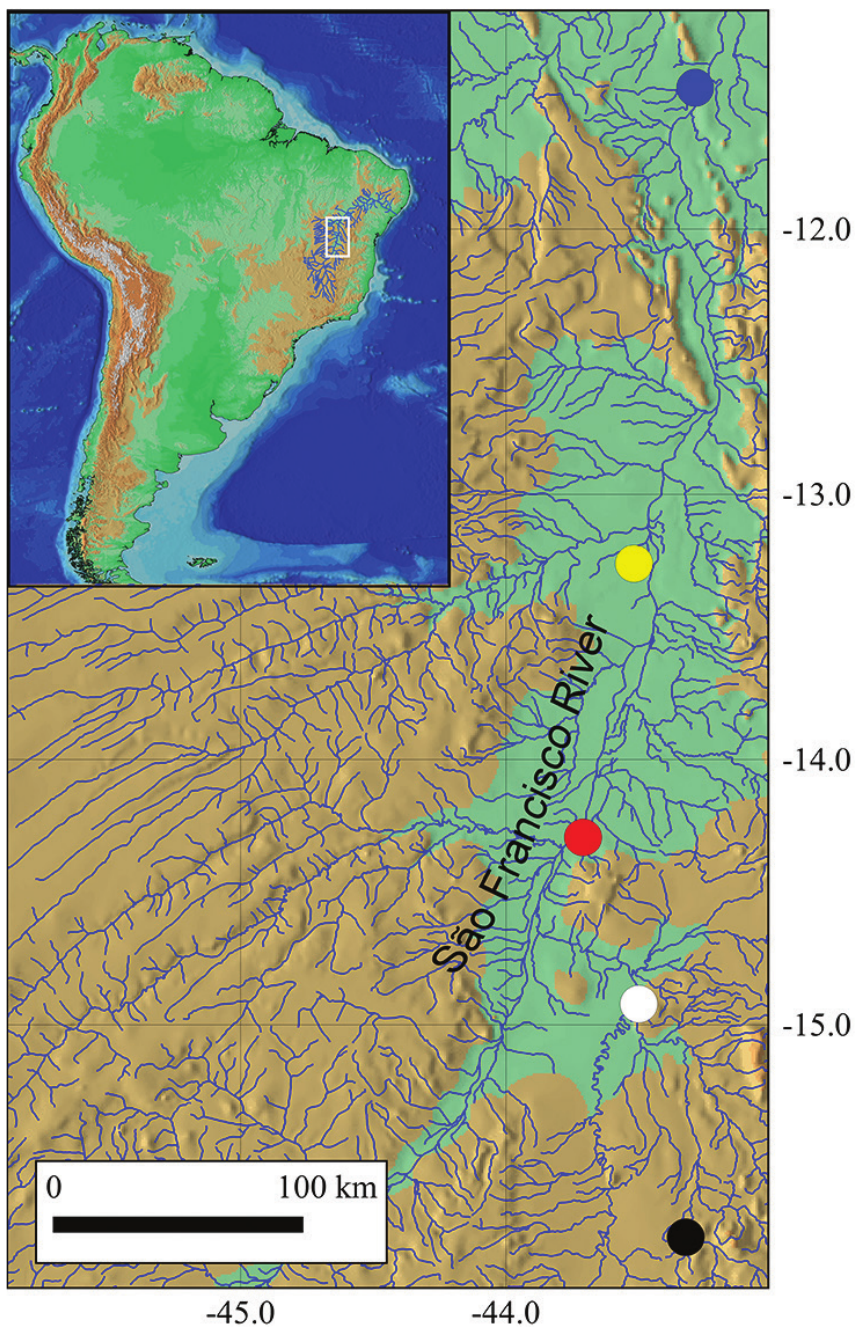
Figure 3. Localities of specimens belonging to species of the Hypsolebias magnificus complex used in this study: black dot, H. hamadryades ; white dot, H. magnificus ; red dot, H. gardneri ; yellow dot, H. harmoni- cus ; blue dot, H. picturatus